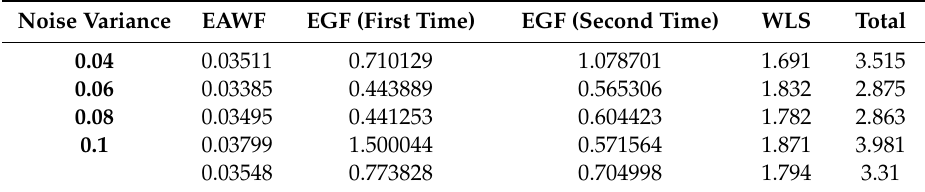
Table 18. Computational complexity results of all the filters in the proposed method for the real SAR image 3 (600 ×